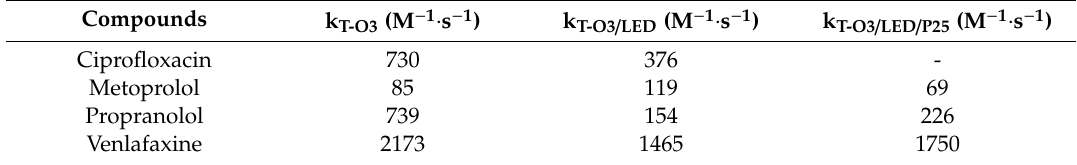
Table 3. Apparent rate constant values of the ozonation process in semi-continuous